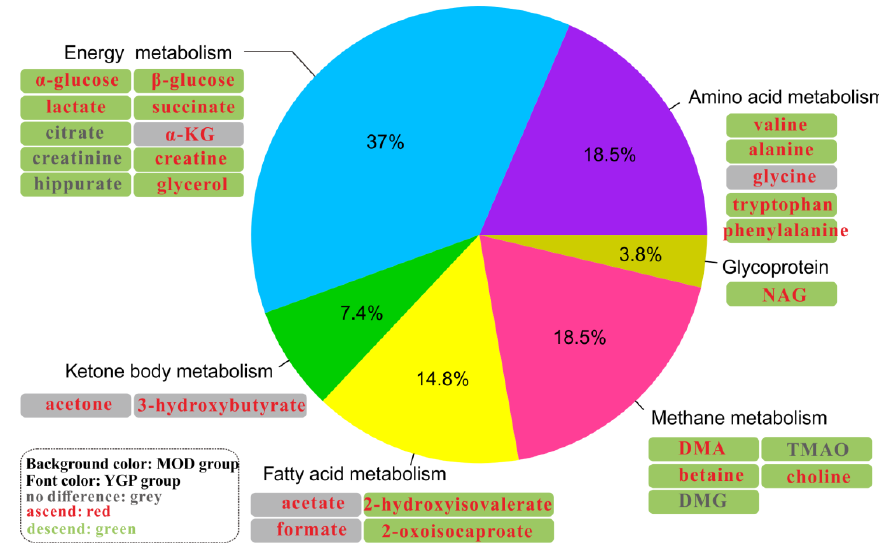
Figure 5. The distribution of 27 di ff erential metabolites. The background color represents the MOD group vs. CON group, and color of font represents the YGP group vs. MOD group. Red means ascending, green means descending, and grey meansno significant